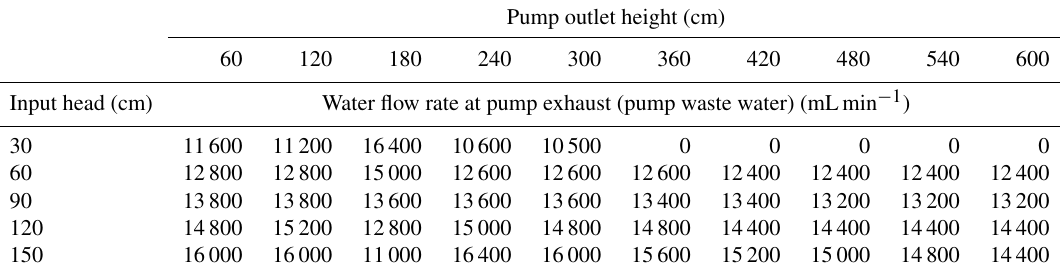
Table 3. The pump exhausted water flow rate variation with input head and outlet height.